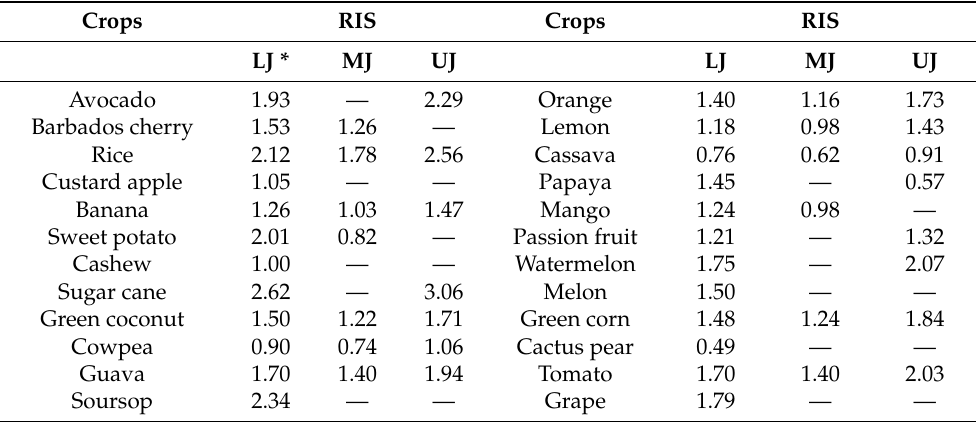
Table 4. Relative irrigation supply in the three Jaguaribe River